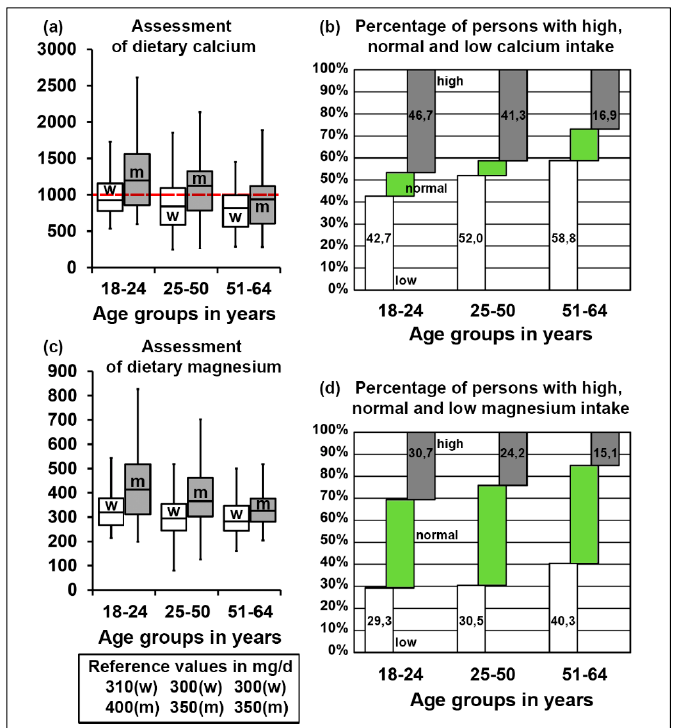
Figure 4. ( a ) Median intake levels of calcium in di ff erent gender and age groups in mg / day. Red dashed line depicts the recommended intake level for calcium, w indicates women, m–men. ( b ) Percentage of persons with a discrepancy between reported calcium intake and the reference values in di ff erent age groups. ( c ) Median intake levels of magnesium in di ff erent gender and age groups in mg / day. Reference values for di ff erent gender and age groups are specified in the table below, w indicates women, m–men. ( d ) Percentage of persons with a discrepancy between reported magnesium intake and the average of reference values in di ff erent age groups. See also Table S2.